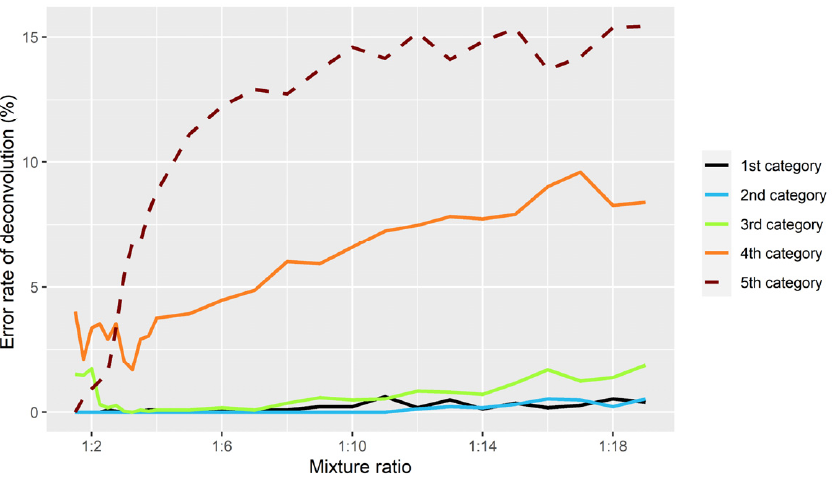
Figure 6. Error rate of KM5.R and KM2.R’s deconvolution analysis in each category for inferring the profiles of the minor contributors in non-parent–child in silico mixtures.